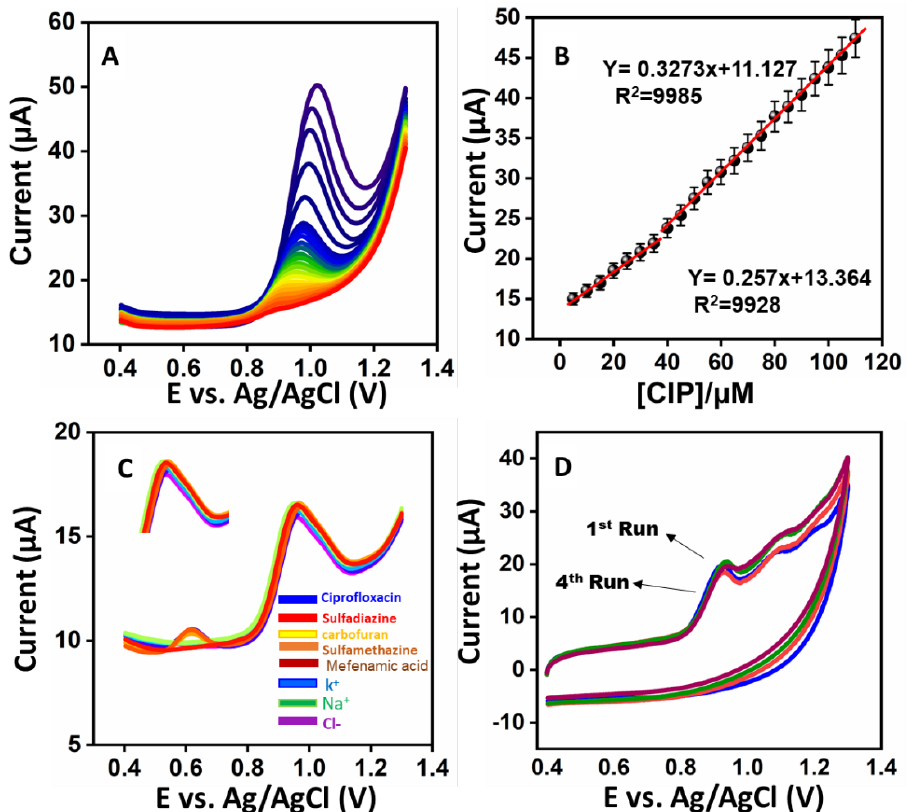
Figure 8. ( A ) DPV measurements of GCE/ZnWO 4 /CB with various addition of CIP range from 0.02 to 120 µM with N 2 immersed in 0.05 M PBS (pH 7); ( B ) linear graph along oxidation peak current and different concentration of CIP); ( C ) interference studies of various interrupting compounds; and ( D ) repeatability study with N 2 immersed in 0.05 M PBS (pH 7).